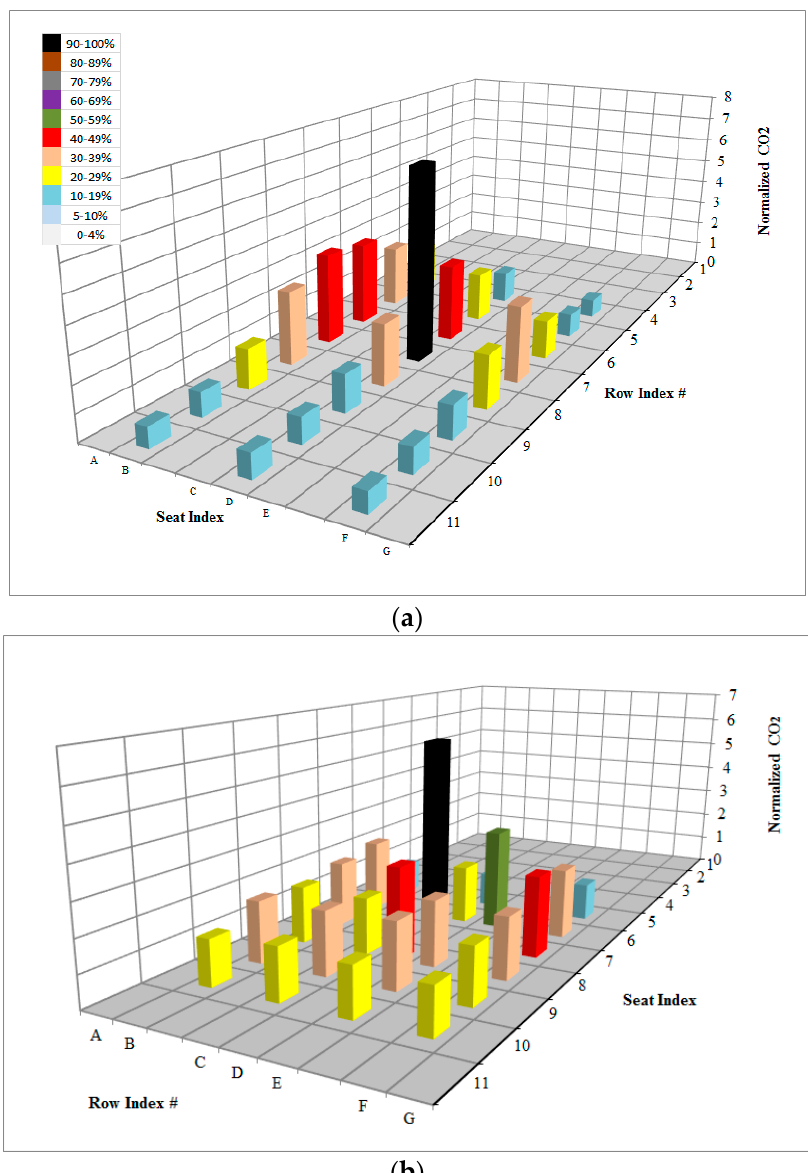
Figure 7. ( a ) normalized CO 2 results for release in seat 7D—Heated case; ( b ) normalized CO 2 results for release in seat 7D—Unheated case.